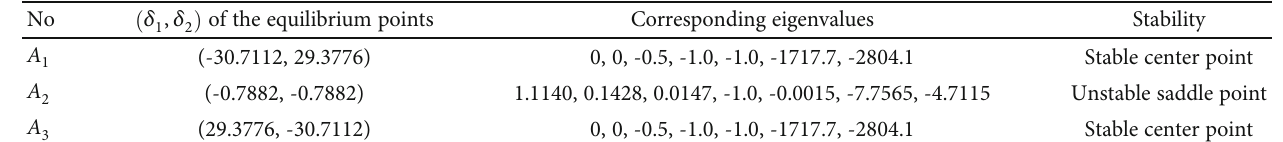
Table 2: Equilibrium points, eigenvalues, and stabilities when k = 0 : 5 .